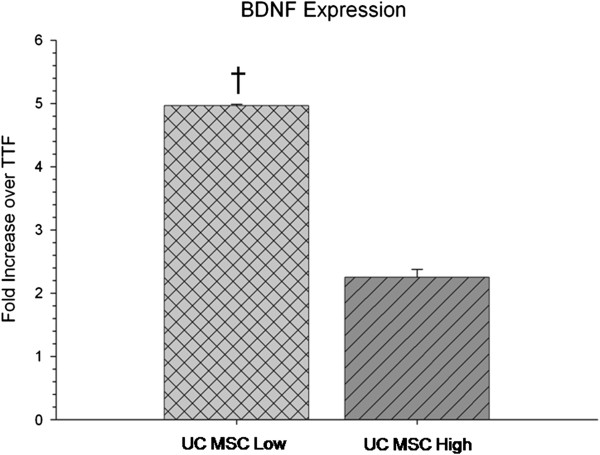
In vitro quantitative RT-PCR of BDNF mRNA expression of umbilical cord mesenchymal stem cells (UC MSCs). A significant decrease in mRNA levels of BDNF was observed in the high-passaged UC MSCs compared to low-passaged UC MSCs. (Note: † significant from high-passage UC MSCs; TTF are control cDNA isolated from mice tail-tip fibroblasts.) Bar graph represents mean value; error bars represents SEM. BDNF, brain-derived neurotrophic factor; SEM, standard error of the mean.